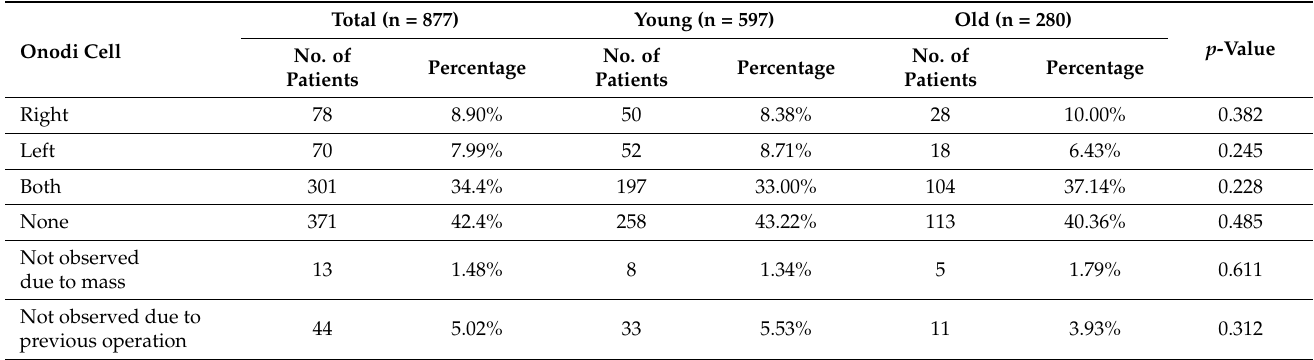
Table 2. Classification of Onodi cell morphology based on preoperative paranasal sinus computed tomography and intraoperative findings.